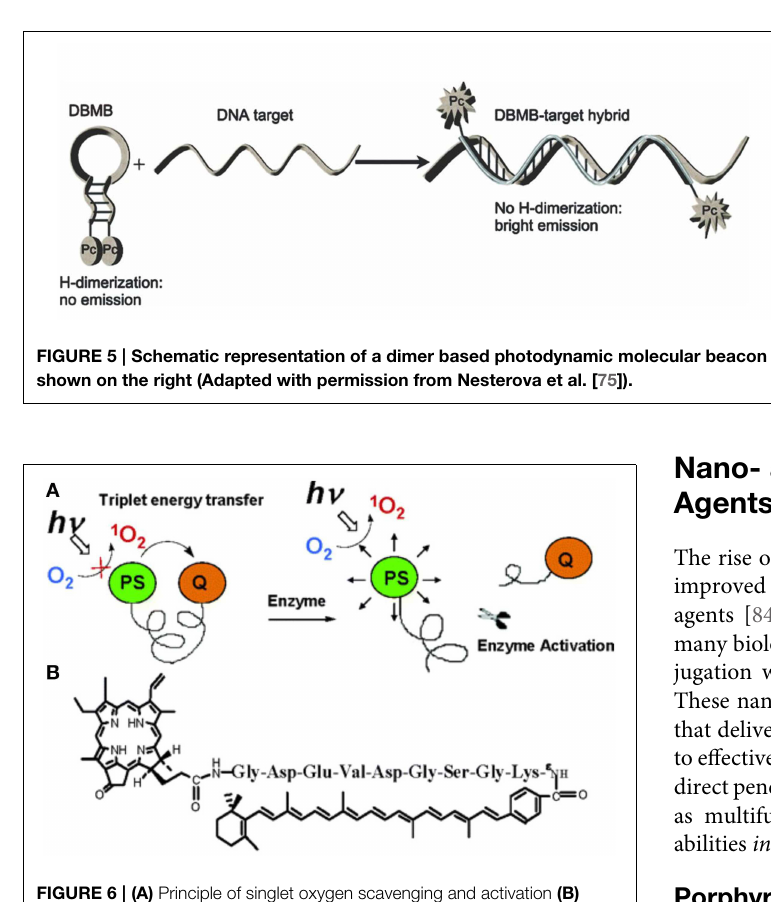
FIGURE 6 | (A) Principle of singlet oxygen scavenging and activation (B) structure of a caspase-3 activatable pyro-peptide-carotenoid photodynamic beacon (Adapted with permission from Chen et al.